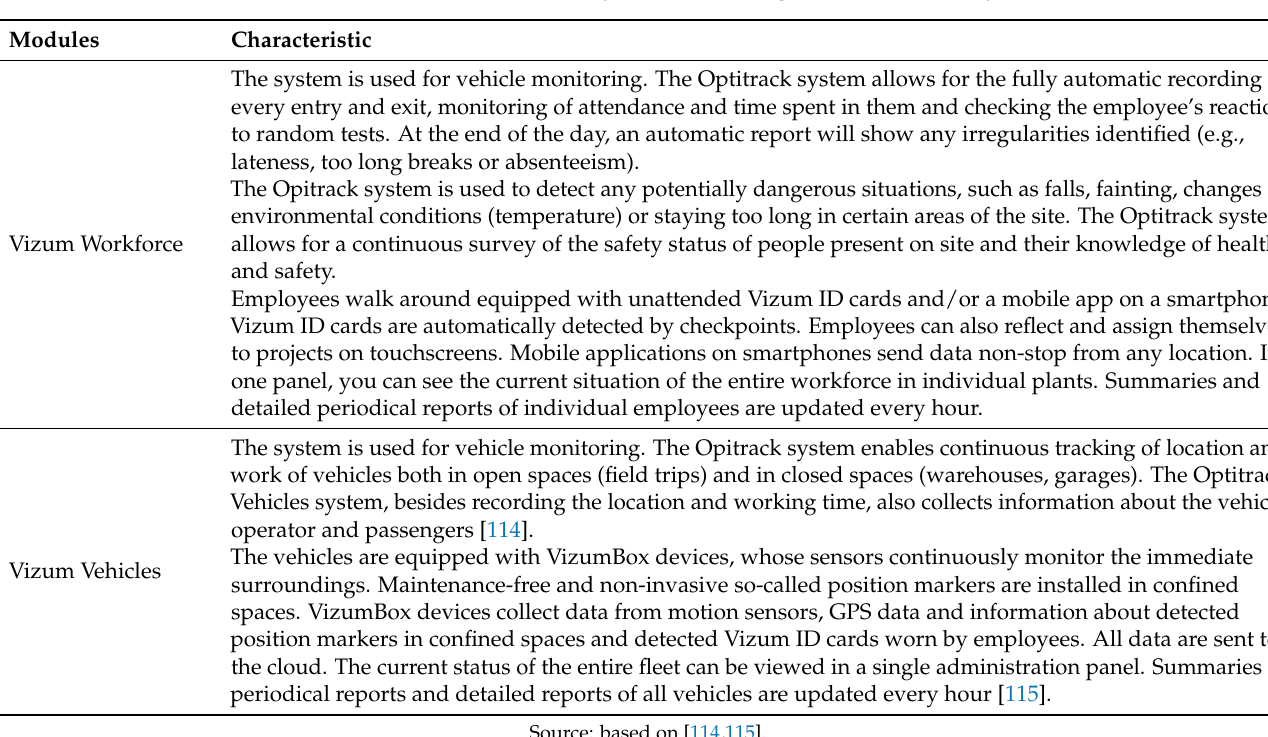
Table 2. Modules of the Vizum system used for digitalisation in